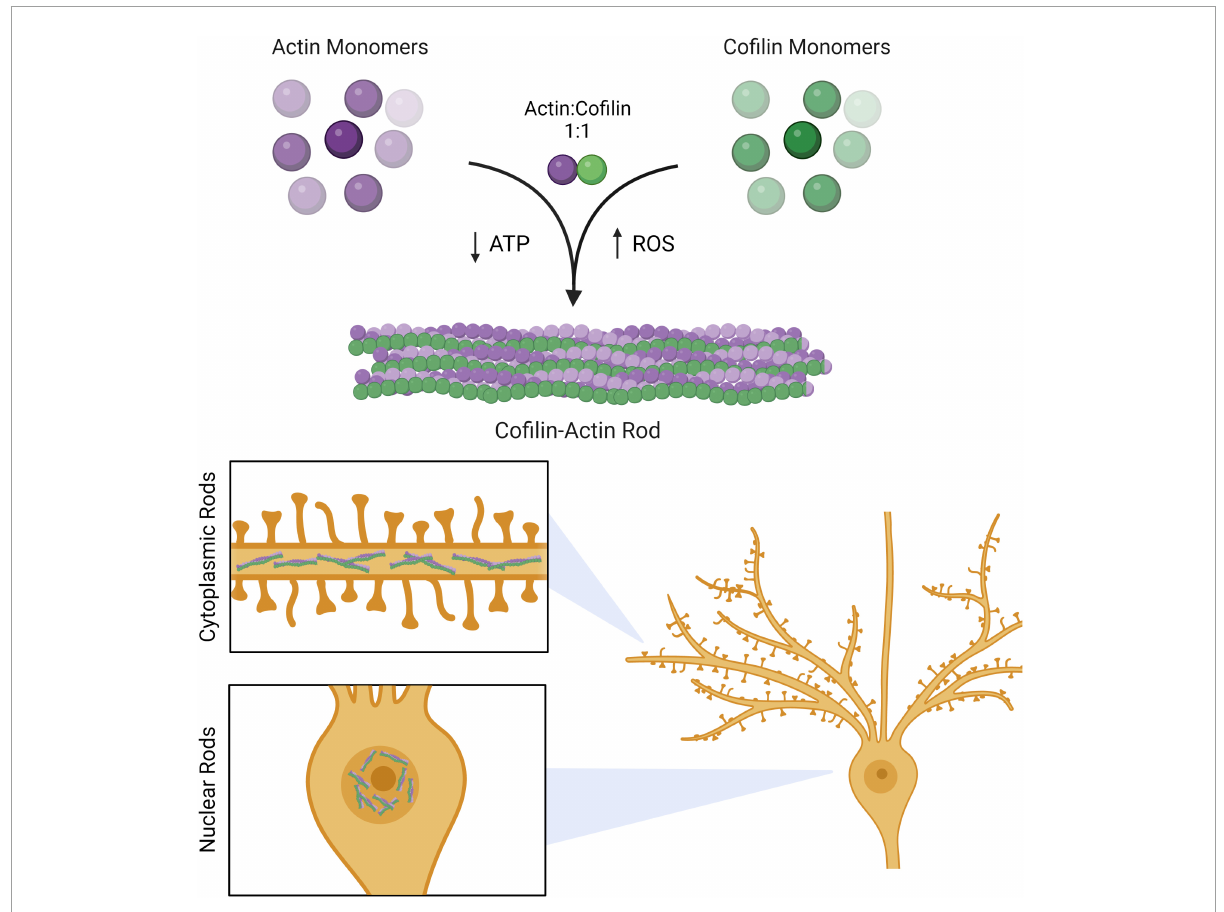
FIGURE1 Cofilin-actin rods in neurons. Actin and cofilin bind to each other in a 1:1 ratio. Persistent cofilin-actin rods can occur under stress conditions, such as ATP depletion or oxidative stress brought upon by ROS. In neurons, these rods accumulate in the cytoplasm of processes (cytoplasmic rods) and in the nucleus (nuclear rods). Created with